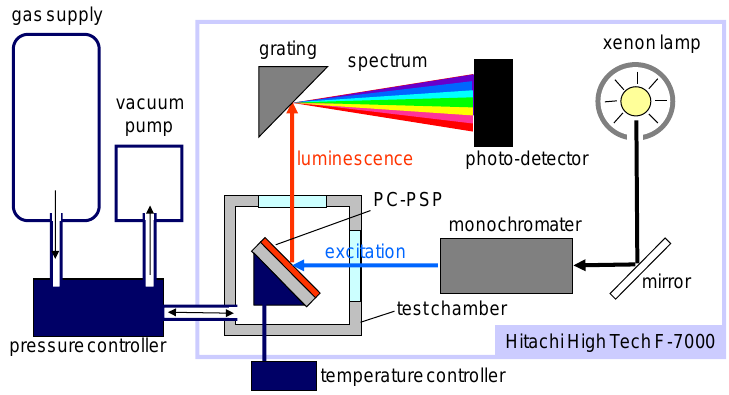
Figure 4. Schematic of the PC-PSP calibration